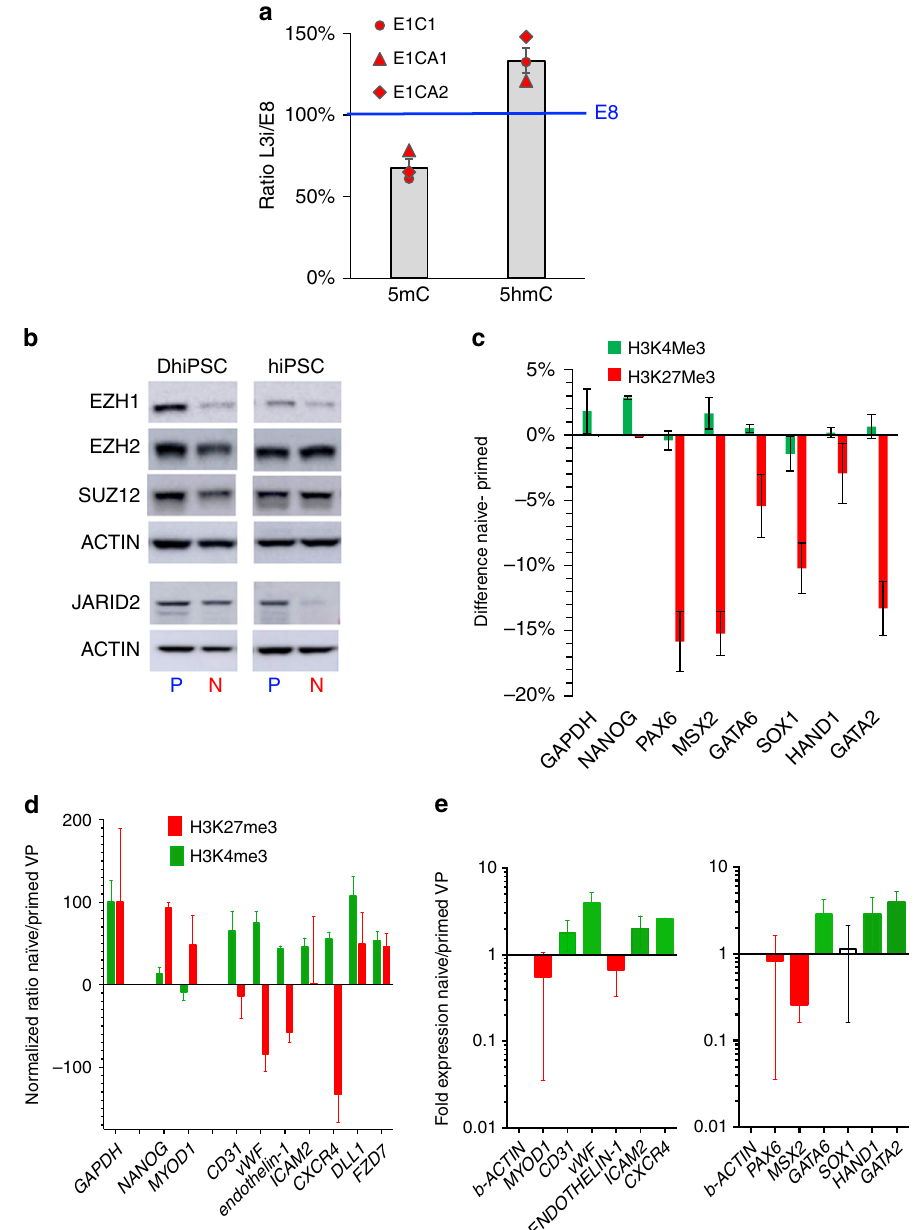
Fig. 9 Epigenetic con fi guration of bivalent and vascular-lineage-speci fi c promoters in primed vs. naïve hiPSC and VP. a Densitometric quantitation of dot immunoblots of genomic DNA samples for global levels of 5-methylcytosine (5mC) and 5-hydroxymethylcytosine (5hmC) in three isogenic pairs of primed vs. naïve DhiPSC. Immunoblot naïve/primed densitometric ratios were determined with ImageJ software at steady state conditions (200 ng), and normalized at 100% for E8 values. b Western blot analysis of PRC2 components (EZH1, EZH2, SUZ12, and JARID2) in primed vs. naïve normal (C1.2) and diabetic (E1C1) hiPSC lysates. c ChIP-qPCR for H3K27me3 and H3K4me3 histone marks at bivalent developmental promoters (e.g., PAX6, MSX2, GATA6, SOX1, HAND1, GATA2) in primed vs. naïve DhiPSC (E1C1). GAPDH and NANOG are controls for actively-transcribed genes. Data are presented as differences in percent input materials of naïve minus primed genomic DNA samples. Error bars represent the SEM of replicates. d ChIP-qPCR for H3K27me3 and H3K4me3 histone marks at vascular developmental promoters in primed vs. naïve VP genomic samples. Data are presented as GAPDH- normalized ratios of percent input materials between naïve and primed VP differentiated from DhiPSC (E1C1). Results are shown as ratios of expression of isogenic N-DVP vs. DVP for GATA2-regulated genes (CD31, vWF, endothelin-1, ICAM2) and genes regulated by histone marks that are known to effect vascular functionality (CXCR4, DLL1, FZD7). GAPDH served as housekeeping control gene; NANOG and MYOD1 represented control promoters that are normally repressed during vascular differentiation. e qRT-PCR gene expression analysis of vascular-lineage genes (left panel) and PRC2-regulated lineage- speci fi c genes (right panel) in DVP vs. N-DVP that were differentiated from isogenic pairs of naïve vs. primed D-hiPSC ( n = 3; E1C1, E1CA1, E1CA2). Fold changes are normalized to beta-actin